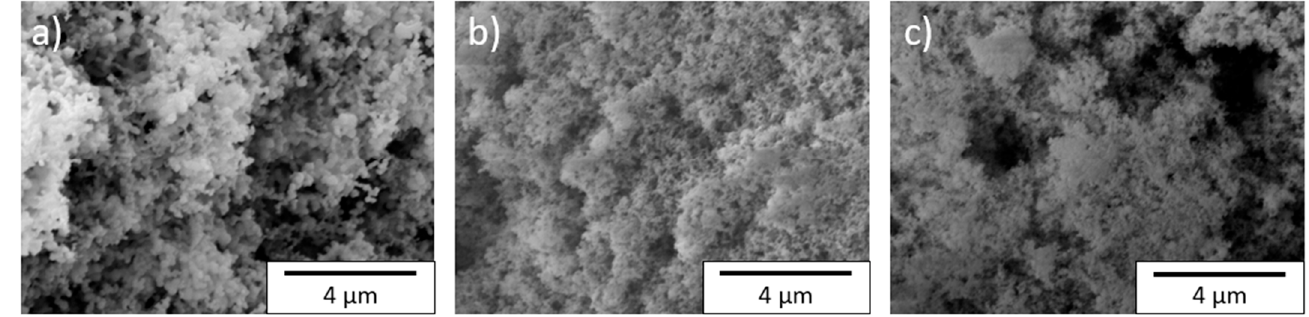
Figure 2. Scanning electrode microscope images of silicon particles at 10,000× magnification: ( a ) NGP, ( b ) TSi, and ( c ) SSN.